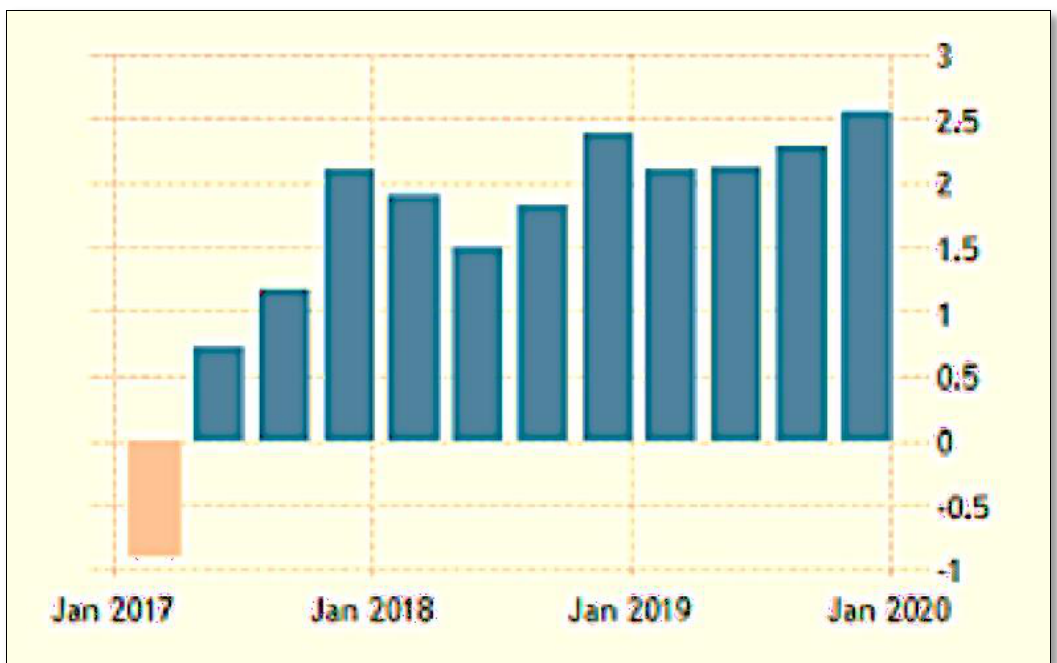
Figure 4. Nigeria's Human Development Index [Historical Index 1870 to 2015] . Source: Author.